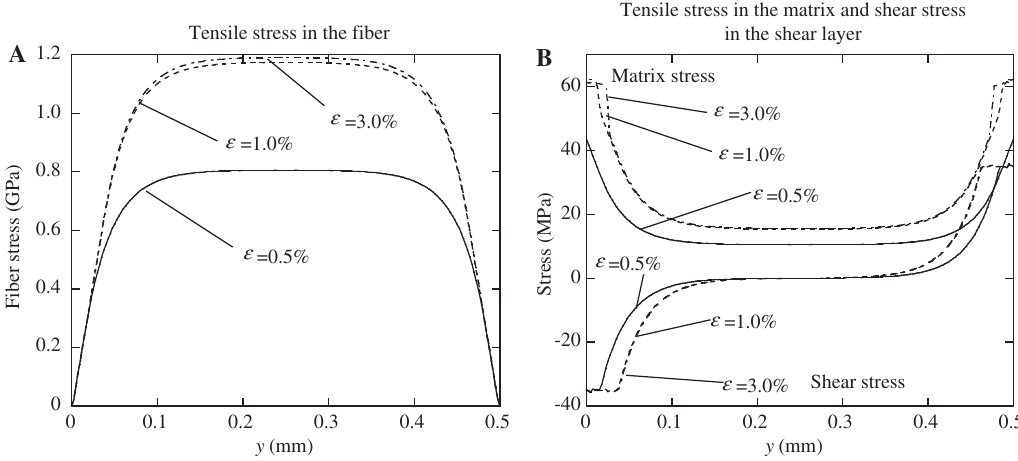
Figure 6 Stress distributions along the fi ber direction obtained by the present analysis for case (B) (almost elastic-perfectly plastic